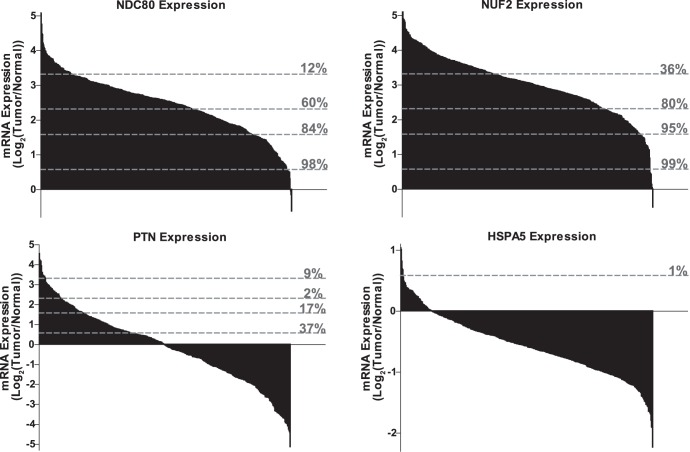
Assessment of gene expression using TCGA ovarian cancer data set.TCGA data set on 494 ovarian serous adenocarcinomas was queried to determine the mRNA expression levels (log2(tumor/normal ratio)) of NDC80, NUF2, PTN, and HSPA5. These data are shown as bar graphs with the grey dashed lines indicating the percentage of samples with 1.5-fold, 3-fold, 5-fold and 10-fold overexpression as compared to unmatched normal samples in the TCGA data set.